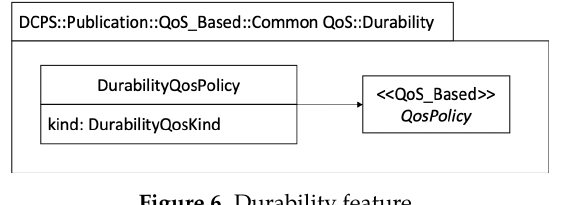
Figure 6. Durability